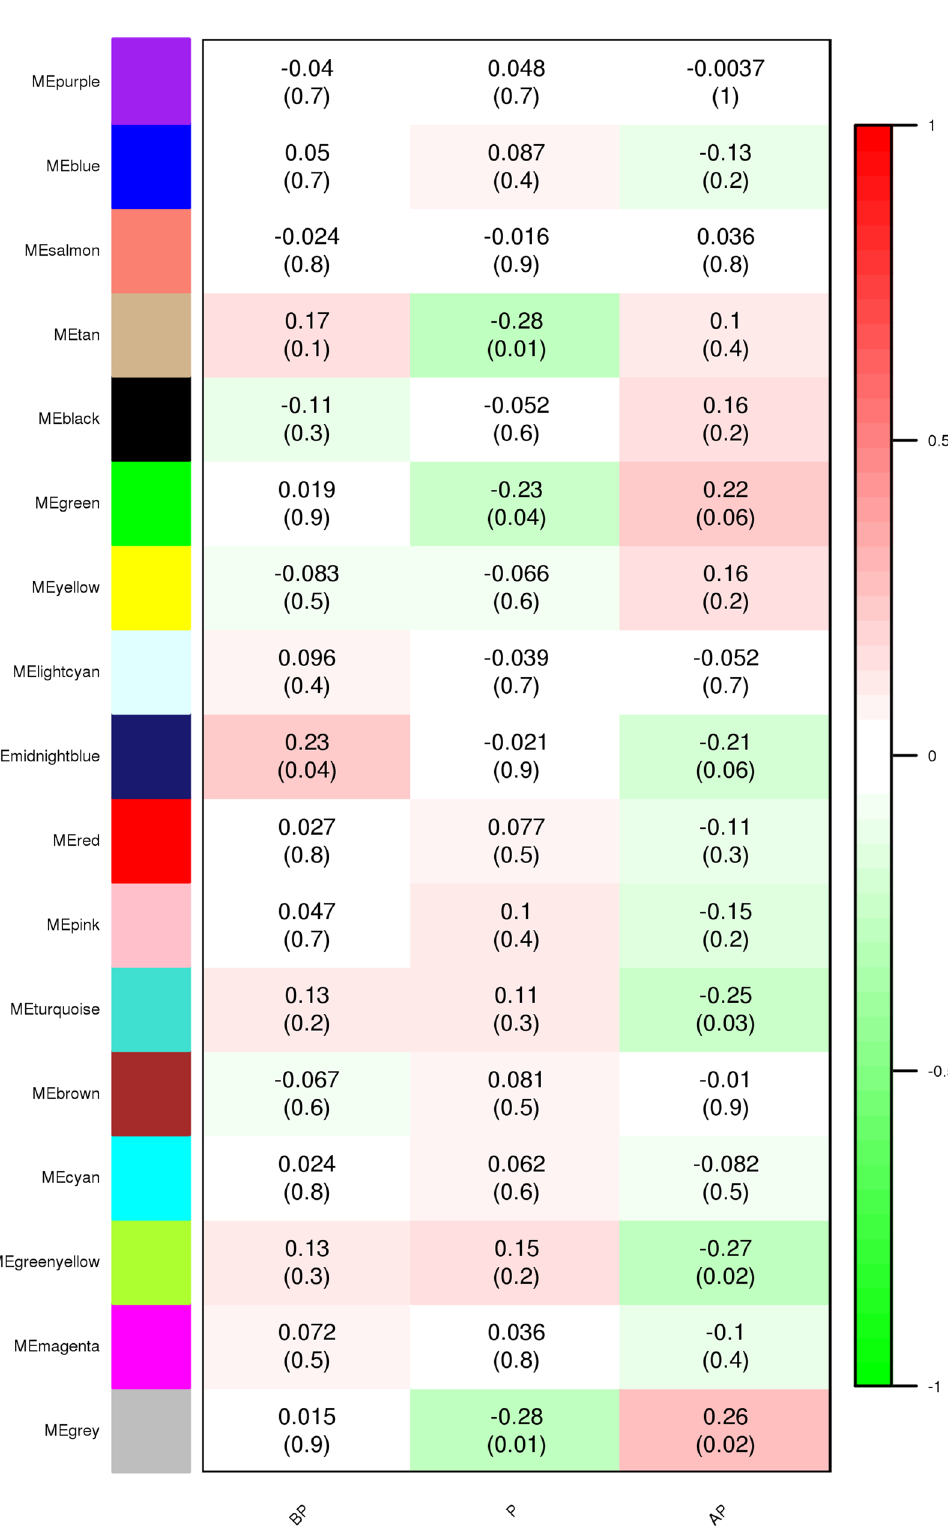
Figure 4. The module trait relationship ( p value) for identified modules (y-axis) in relation with traits (x-axis). X-axis legend: BP = before peak; P = Peak; AP = after